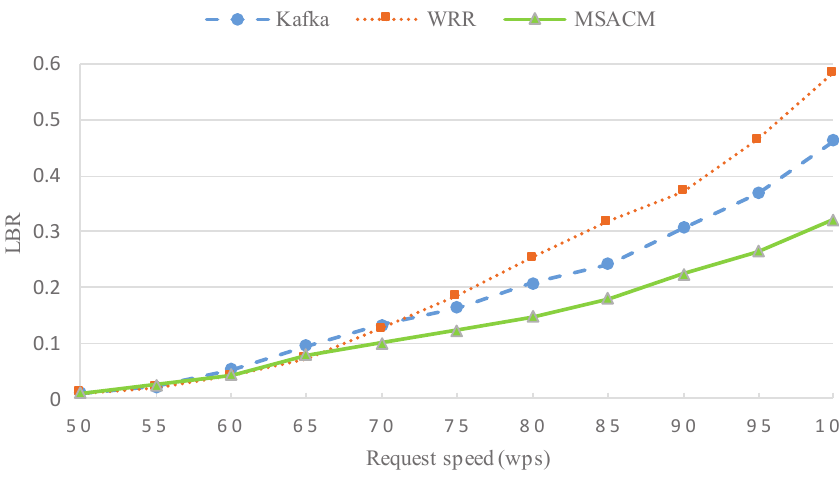
Figure 9. LBR of various number of access service